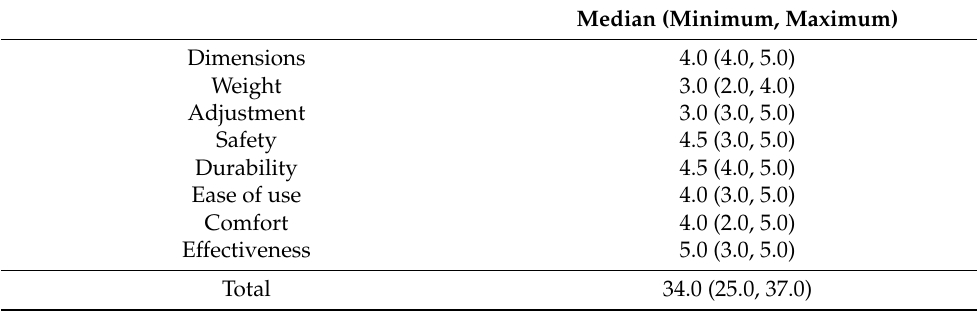
Table 5. Mean Quebec User Evaluation of Satisfaction with assistive Technology 2.0 scale scores.